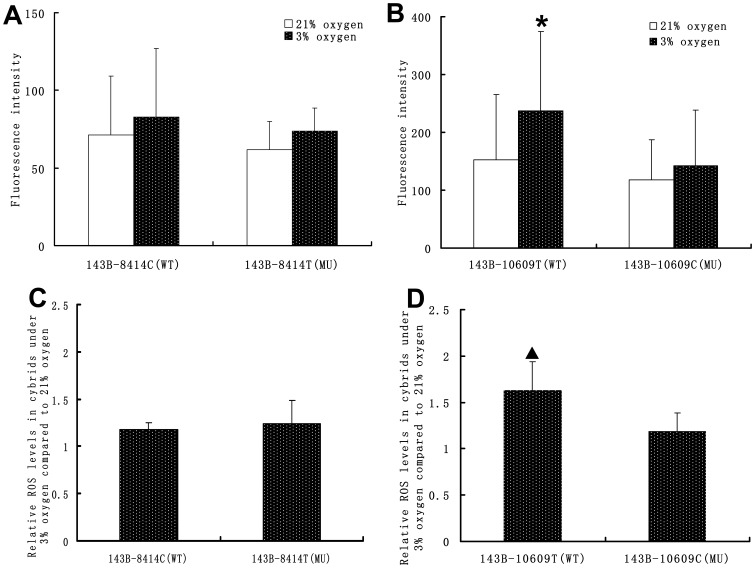
Intracellular ROS in the cybrids under normoxic and hypoxic conditions.First, the normoxic and hypoxic cybrids were cultured in a normoxic incubator (37°C, 5% carbon dioxide, and 21% oxygen) for 48 hours. Second, hypoxic cybrids were shifted and cultured in a hypoxic incubator (37°C, 5% carbon dioxide, and 3% oxygen) for 12 hours. Normoxic cybrids were still cultured in the normoxic incubator for 12 hours. Finally, all of the cybrids were incubated with 2.5 mM DCFH-DA fluorescent probe. The average fluorescence intensity of the cybrids was measured by flow cytometry. The average fluorescence intensity reflected the level of intracellular ROS. All cultures were done in triplicate (n = 3). A. Intracellular ROS in 143B-8414C (WT) and 143B-8414T (MU) under normoxic and hypoxic conditions. B. Intracellular ROS in 143B-10609T (WT) and 143B-10609C (MU) under normoxic and hypoxic conditions. C. The increasing rate of intracellular ROS relative to normoxic conditions in the 143B-8414C (WT) and 143B-8414T (MU) cybrids. D. The increasing rate of intracellular ROS relative to normoxic conditions in the 143B-10609T (WT) and 143B-10609C (MU) cybrids. Error bars indicate the standard deviation. *P<0.05; significantly different from culture under 21% oxygen. ▴ P<0.05; significantly different from 143B-10609C (MU) cybrids.